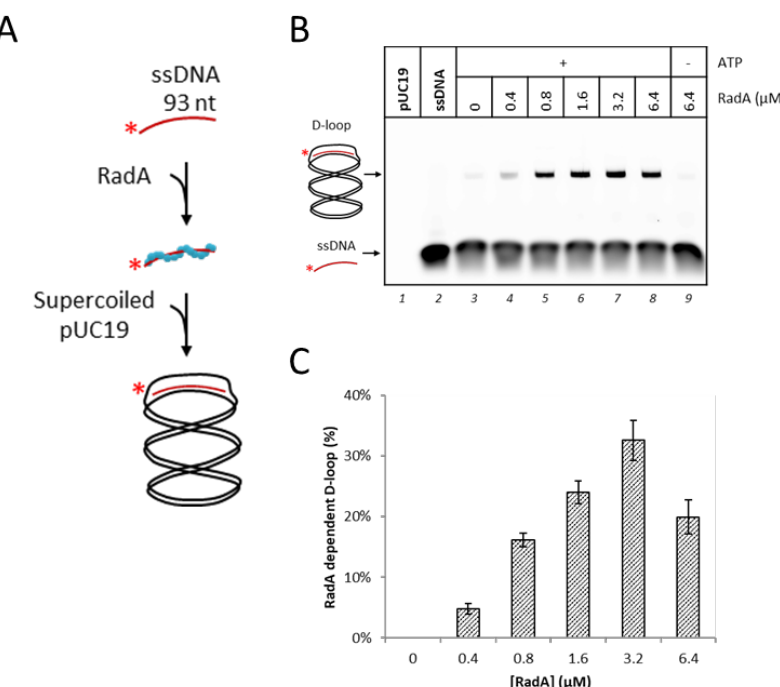
Figure 1. P. abyssi RadA recombinase activity catalyzed displacement-loop (D-loop) formation. ( A ) Schematic representation for the D-loop formation assay. Labeled linear ssDNA (93 nt) was incubated first with RadA to form nucleoprotein filaments before adding the purified supercoiled plasmid pUC19 for further homology search. ( B ) D-loop formation assay with increased quantity of RadA. An amount of 25 nM of labeled ssDNA (93 nt) was incubated with RadA for 10 min at 65 °C. Then, 25 nM of purified supercoiled pUC19 was added and incubated for another 10 min. DNA products were separated on a 1.2% native agarose gel and visualized by fluorescence. ( C ) Histogram representation of the D-loop formation assays for a range of RadA as observed in ( B ). RadA-dependent D-loop (%), densitometry measurement of formed D-loop as a percentage of total lane densitometry after data normalization and the D-loop background from lane 3 was subtracted. Experiments were performed in